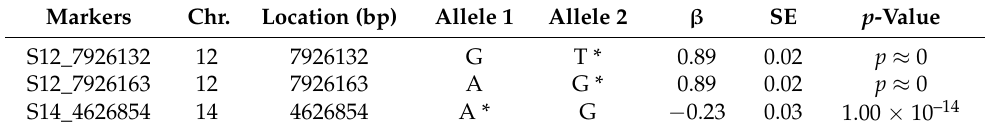
Table 1. Summary statistics of selected resistance-linked single nucleotide polymorphism (SNP) markers from genome-wide association study (GWAS)